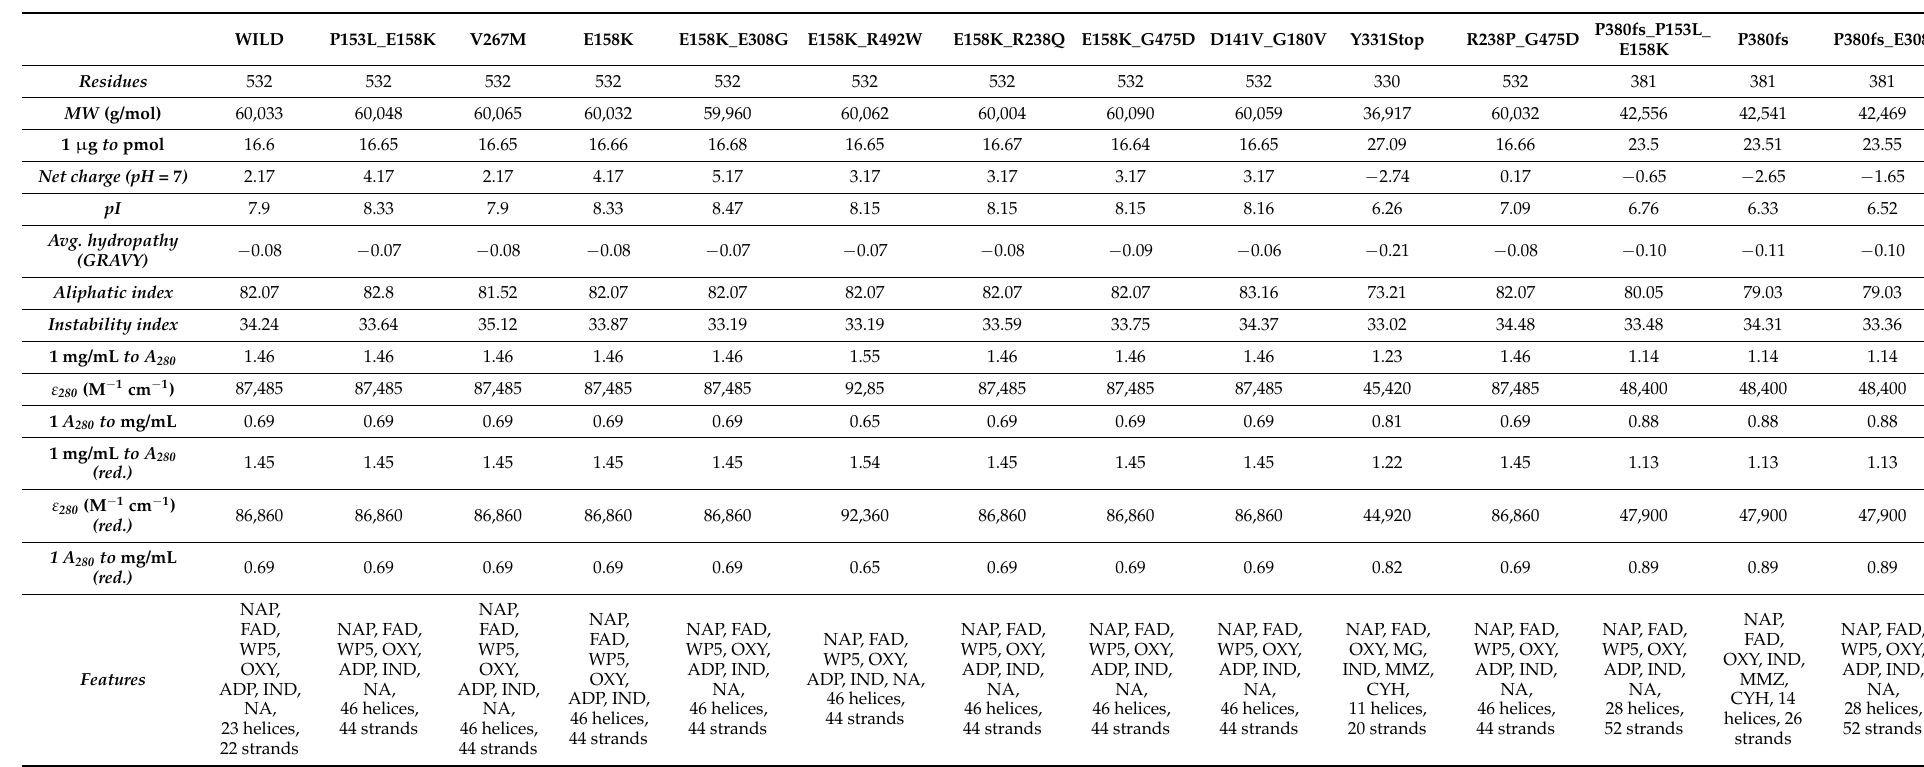
Table 2. Biochemical and physical changes prediction between wild-type and mutated FMO3 . The ProtParam computed features included the molecular weight, theoretical pI, amino acid composition, atomic composition, instability index, aliphatic index, and grand average of hydropathicity (GRAVY). Analyses of such biochemical and physical parameters showed a decreased global instability from wild-type to mutated FMO3 protein encoded by FMO3 gene carrying SNVs